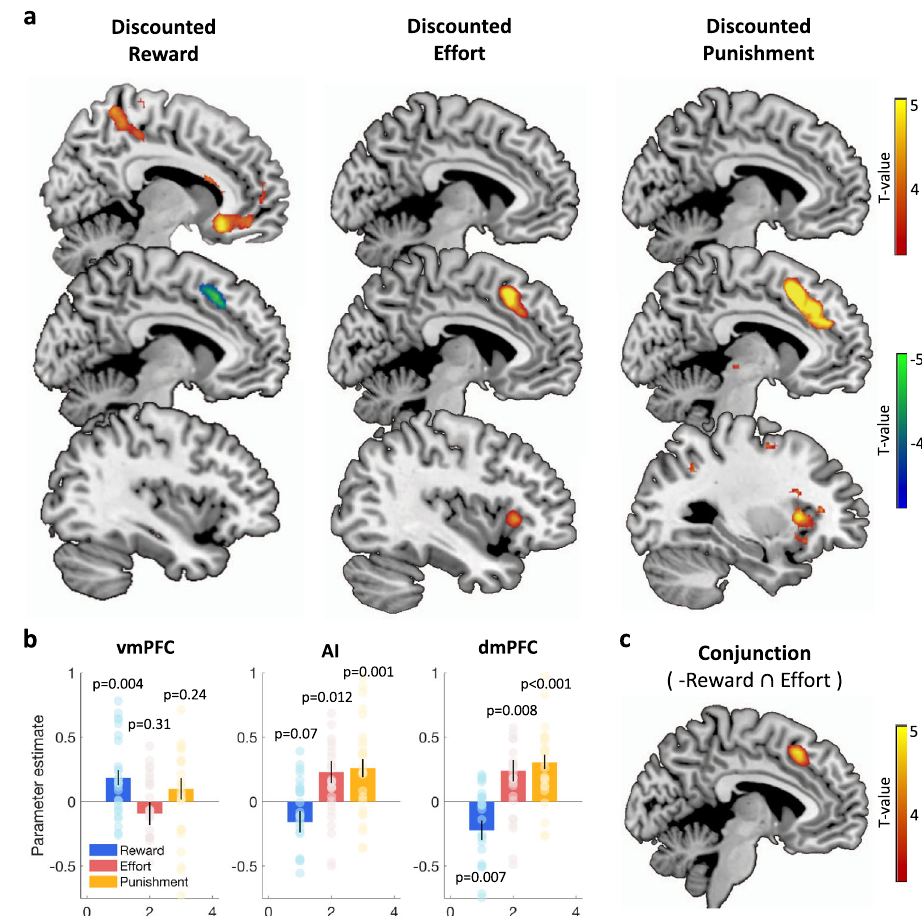
Fig. 3 | Neural correlates oftimepreferences.a Statisticalparametric map (SPM) of discounted reward (chosen minus unchosen option discounted value), dis- counted effort and discounted punishment (chosen minus unchosen option dis- countedcost)duringintertemporalchoice,atthetimeofdeliberation.Positiveand negative effects are shown with yellow-red and green-blue color codes. b Regression coef fi cients (betas) of discounted reward (blue), discounted effort